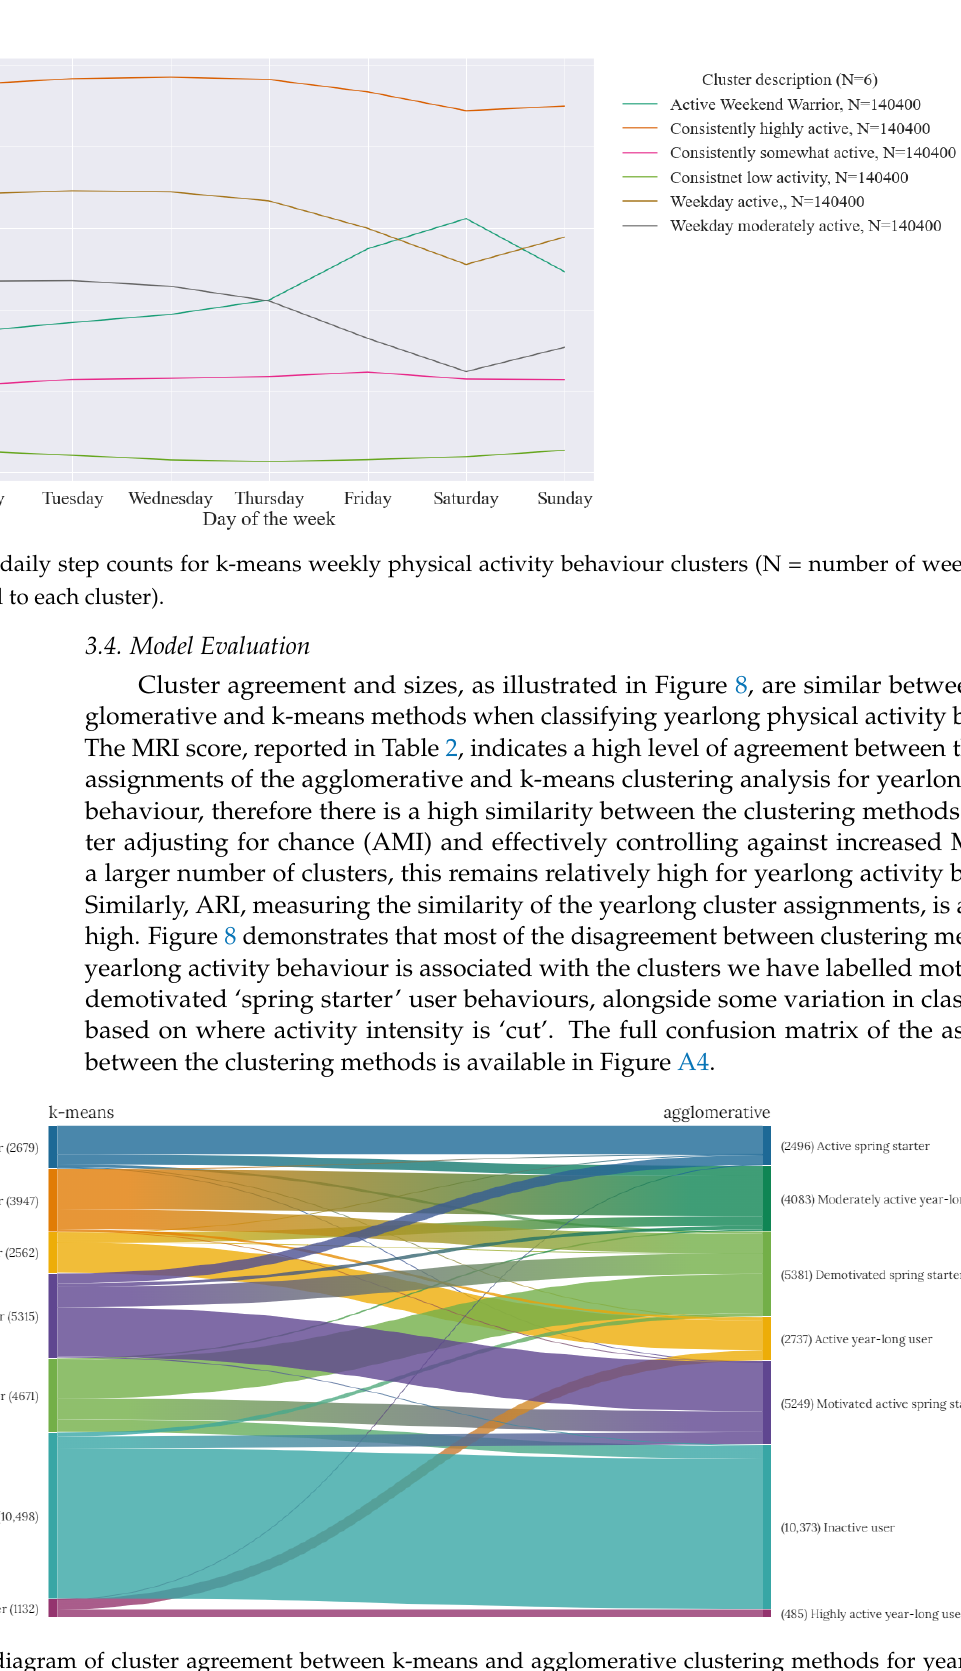
Figure 8. Sankey diagram of cluster agreement between k-means and agglomerative clustering methods for yearlong physical activity behaviour. The thickness the line the indicates the number of years of behaviour assigned to both the corresponding k-means and agglomerative